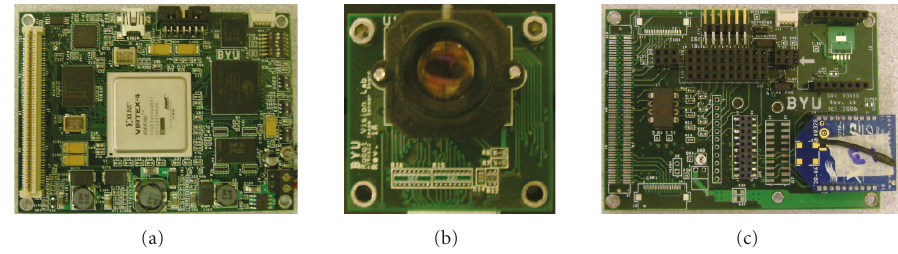
Figure 8: Hardware components: (a) Helios FPGA board, (b) CMOS imager, and (c) AVT daughter board.